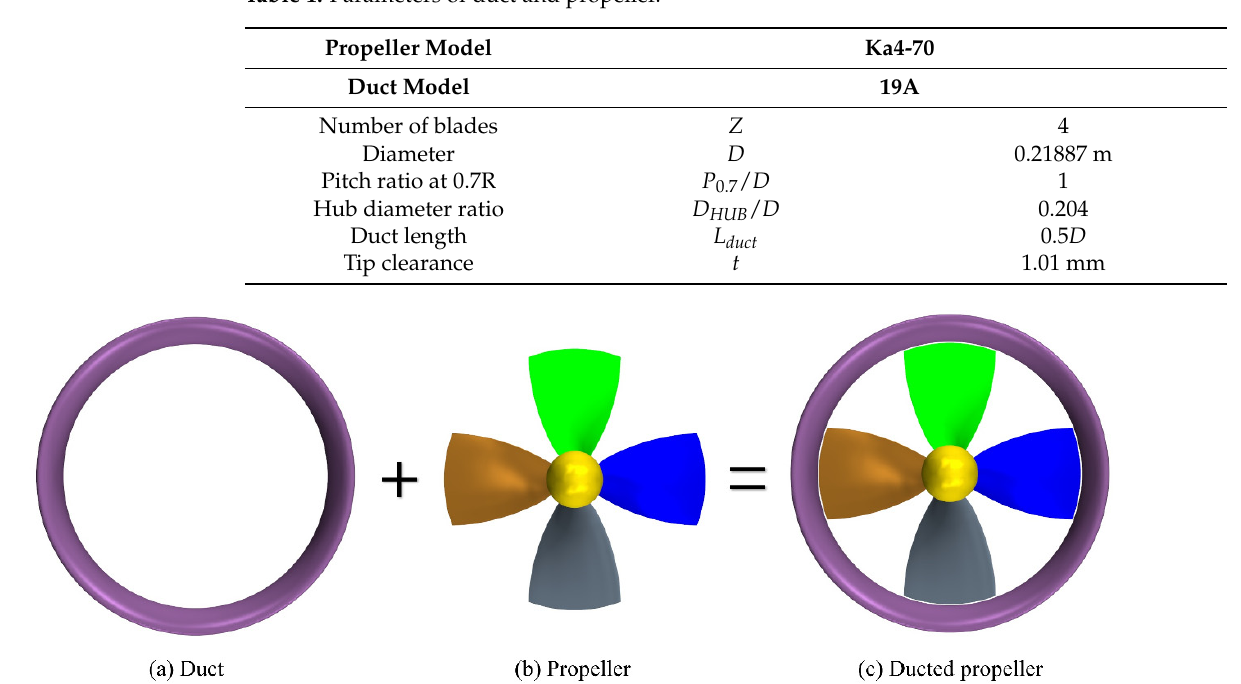
Table 1. Parameters of duct and propeller.